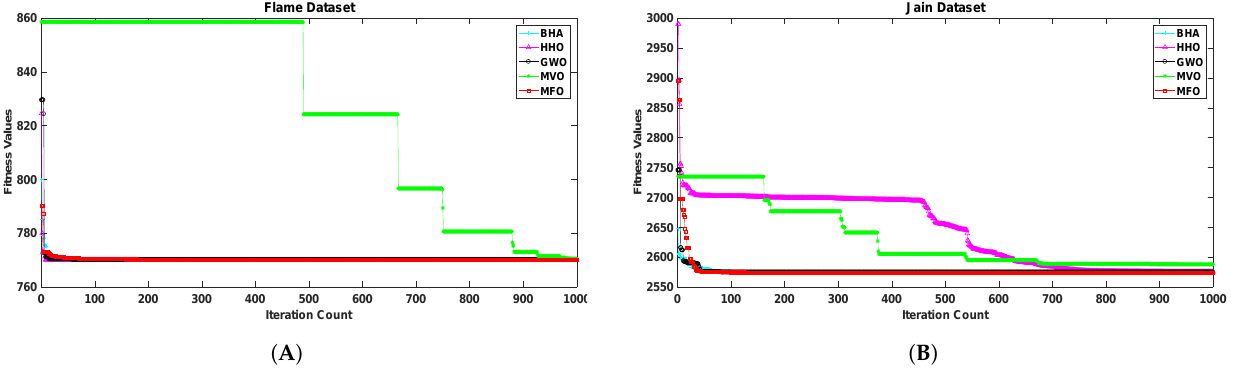
Figure 1. Variation in the best fitness values of algorithms for datasets ( A ): Flame, ( B ): Jain with respect to